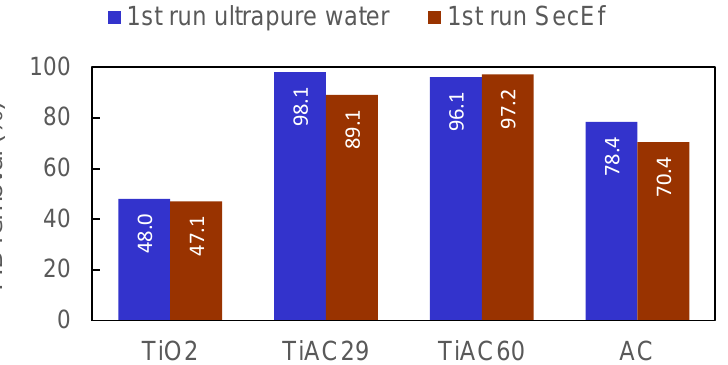
Figure 14. Comparison of the MB removal percentage for the assays performed in ultrapure water (first run ultrapure water) and real wastewater (first run SecEf); irradiation time = 90 min.